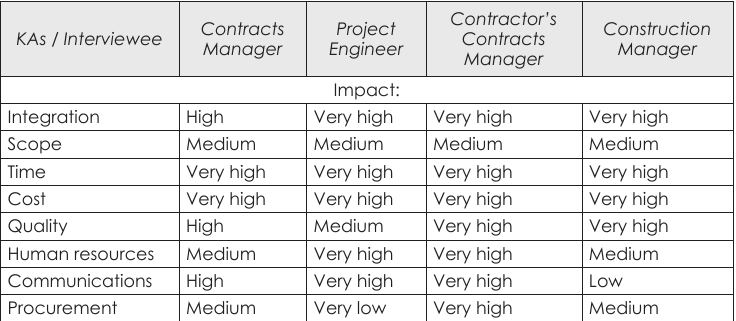
Table 10: Risks’ impact perceptions on the other PMI knowledge areas in Case